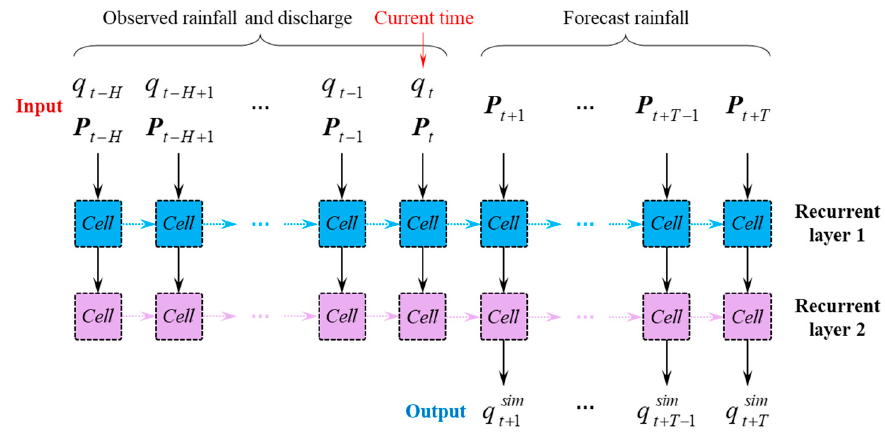
Figure 4. Data flow schematic diagram of architecture 1. Water 2020 , 12 , 912